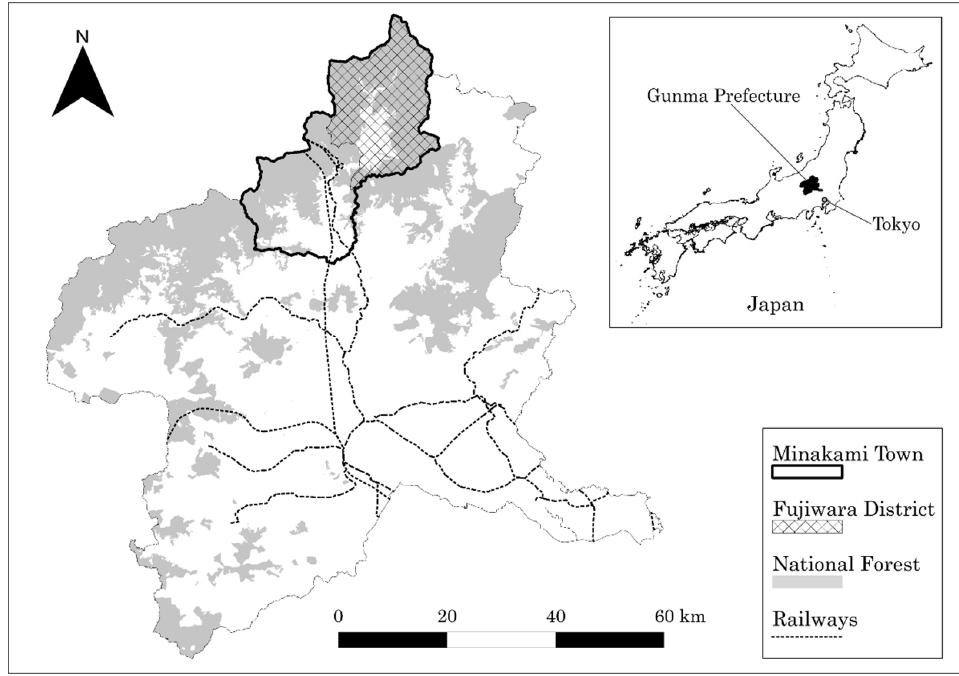
Figure 1. Map showing Fujiwara District in Minakami Town, Gunma Prefecture, Kanto Region, Japan (extracted from [10]).